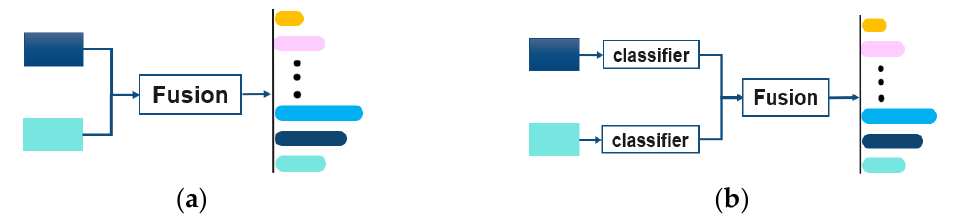
Figure 12. Different stages of integration: ( a ) early fusion; and ( b ) late fusion. Table 8. Comparison of testing results with different fusion methods. Region